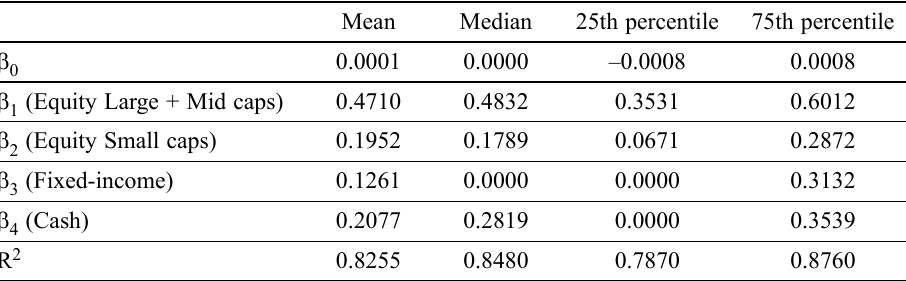
Table 3. Summary statistics of the style